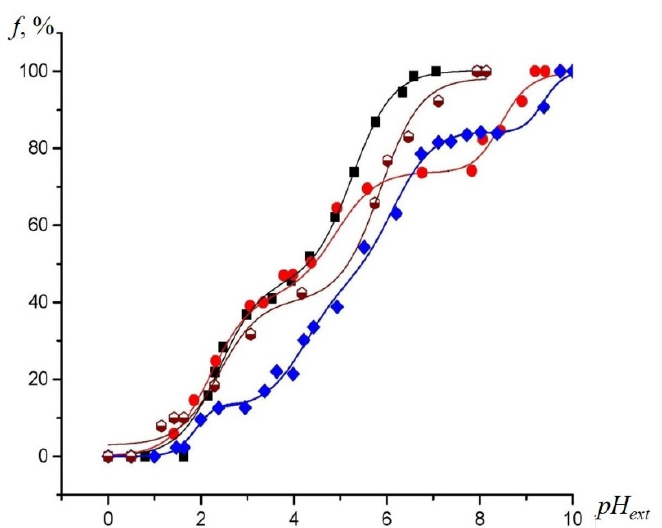
Figure 4. Experimental EPR titration curves for the NR at 293 K obtained by plotting the fast- and slow-motioned component of the EPR spectra of the NR in the non-protonated form ( f ) vs. pH ext in aqueous solution ( black squares ), and inside the SiO 2 ( red circles), TiO 2 (50%)–SiO 2 , ( brown hexagons ) and TiO 2 (7%)–SiO 2 , ( blue diamonds ), respectively.